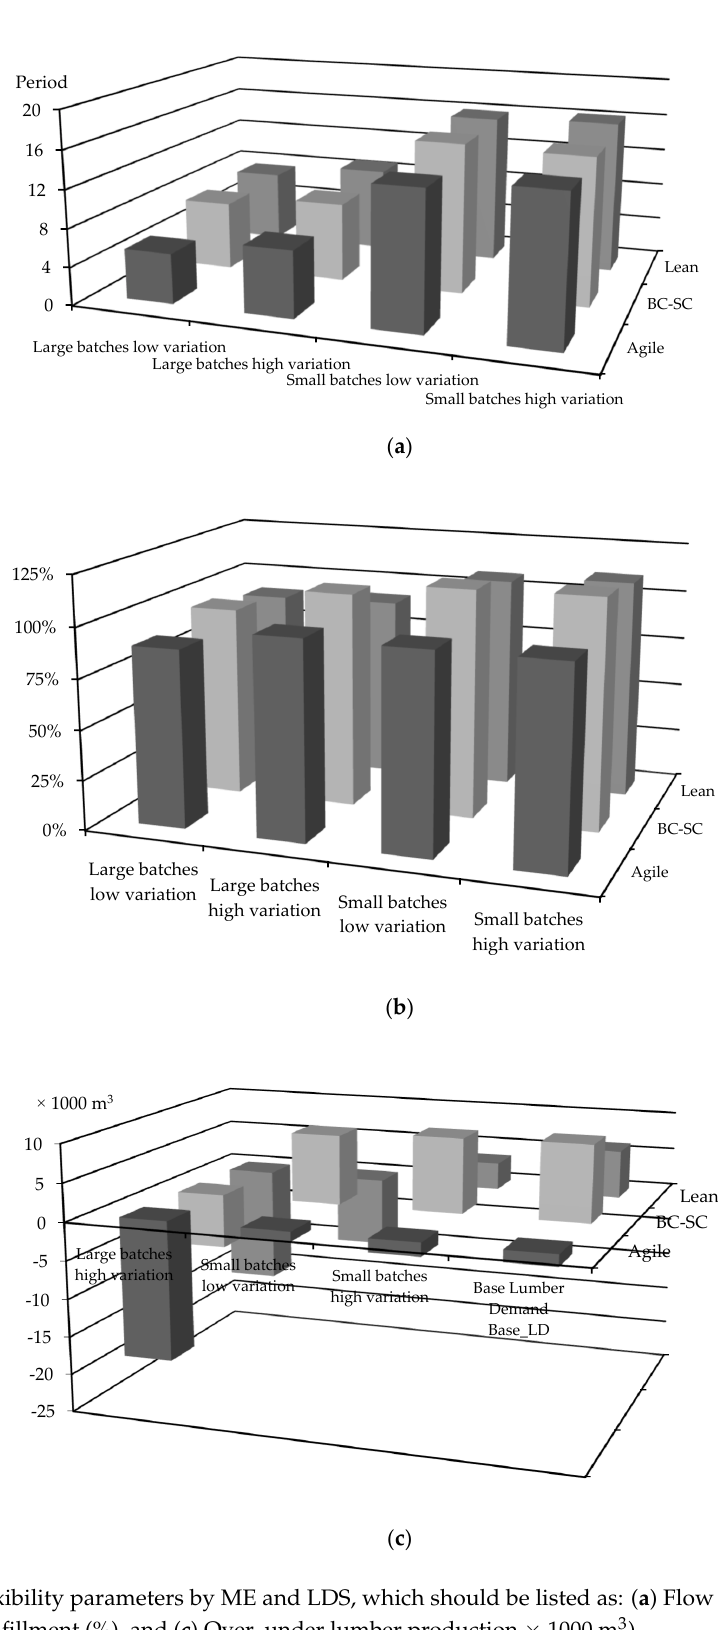
Figure 3. Flexibility parameters by ME and LDS, which should be listed as: ( a ) Flow time (periods), ( b ) Orders fulfillment (%), and ( c ) Over–under lumber production × 1000 m 3 ).